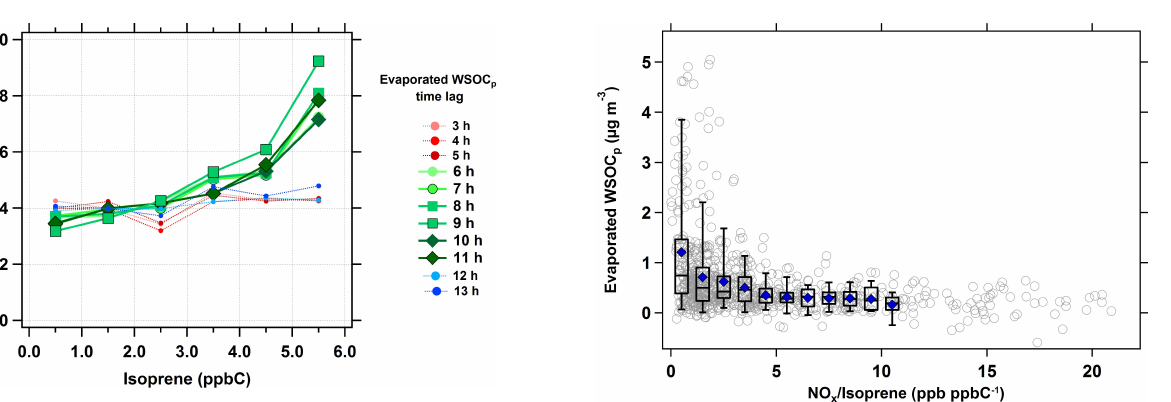
Figure 5. Scatter and box plots of evaporated WSOC p (9h time lag) as a function of NO x / isoprene ratio (ppbppbC − 1 or mol(molC) − 1 in the summer. Bins were chosen to include at least 50 data points. For each bin, mean (blue marker), median (hori- zontal black line), 25th and 75th percentiles (lower and upper box values), and 5th and 95th percentiles (vertical lines) are shown.